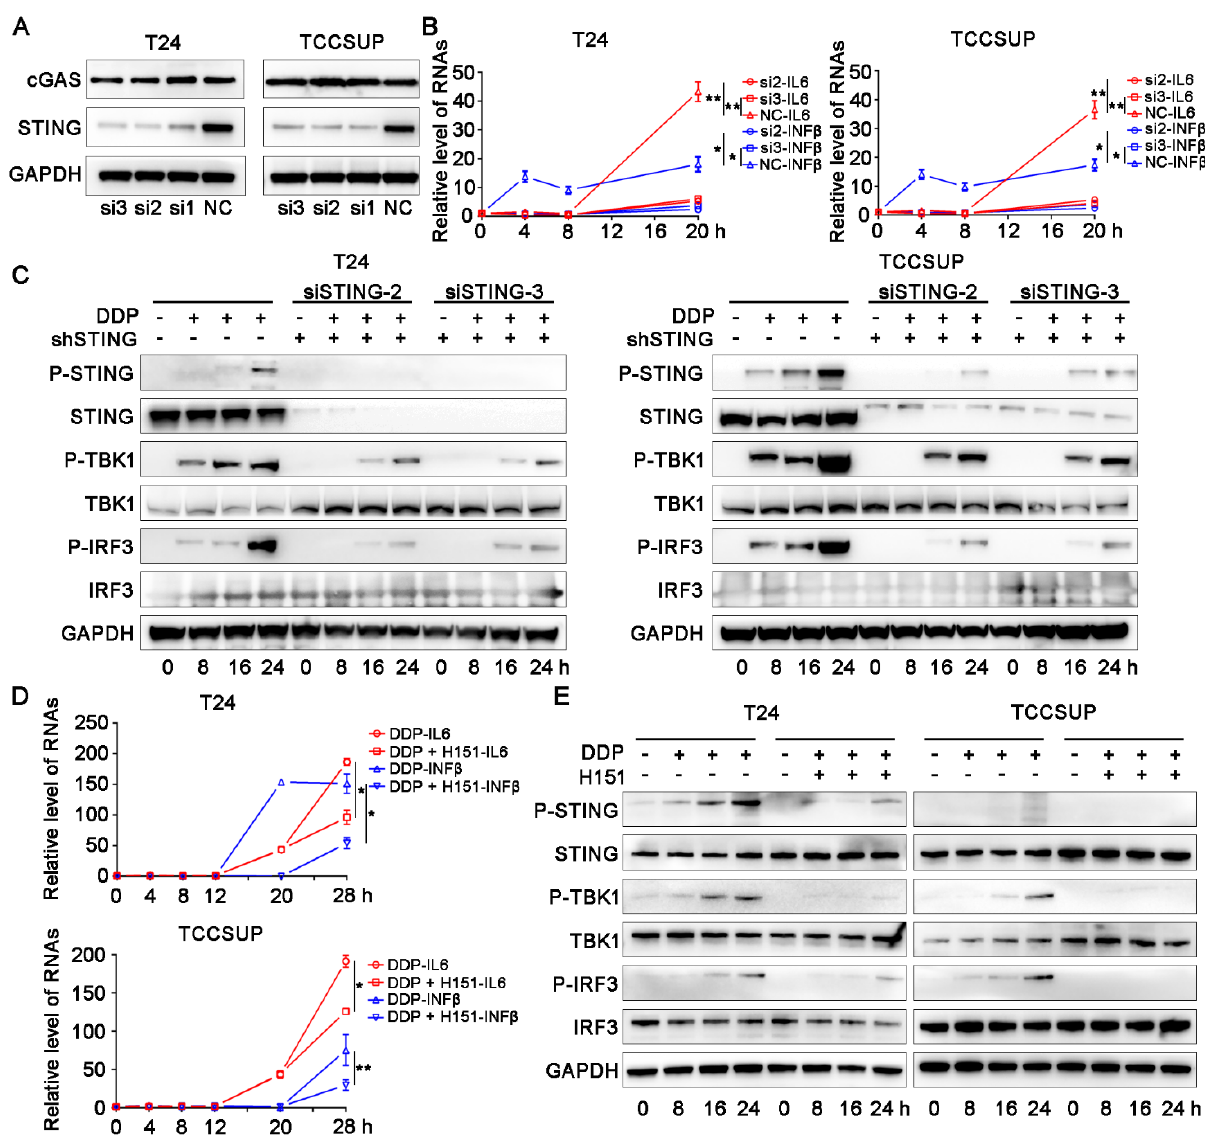
Figure 3. STING targeting siRNAs and STING specific inhibitor H151 significantly reversed cisplatin related immune effects. ( A ) Knockdown efficiency validation of STING in T24 and TCCSUP cell lines. GAPDH was used as control protein. ( B ) T24 and TCCSUP cell lines were treated with non- targeting (Scramble, Scr) or two STING-targeting siRNA (si2 and si3) for 48 h before treatment with 2 μg /mL cisplatin for 0 h, 4 h, 8 h, 12 h, 16 h, 20 h, respectively. IFN- β mRNA and IL -6 mRNA were then analyzed by qRT-PCR. ( C ) Western blotting results of key proteins involved in cGAS-STING pathway in T24 and TCCSUP cell lines treated with non-targeting (Scramble, Scr) or two STING- targeting siRNA (si2 and si3) for 48 h before treatment with 2 μg /mL cisplatin for 0 h, 8 h, 16 h, 24 h, respectively. GAPDH was used as control protein. ( D ) T24 and TCCSUP cell lines were co-treated with DMSO or H151 and 2 μg /mL cisplatin for 0 h, 4 h, 8 h, 12 h, 20 h, 28 h, respectively. IFN- β mRNA and IL-6 mRNA were then analyzed by qRT-PCR. ( E ) Western blotting results of key proteins involved in cGAS-STING pathway T24 and TCCSUP cell lines co-treated with DMSO or H151 and 2 μg /mL cisplatin for 0 h, 8 h, 16 h, 24 h, respectively. GAPDH was used as control protein. * p < 0.05, ** p < 0.01 .